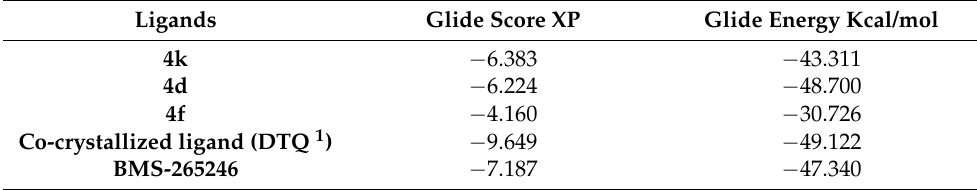
Table 5. Binding free energy of 4d , 4k , 4f , BMS-265246 and DTQ at the active site of